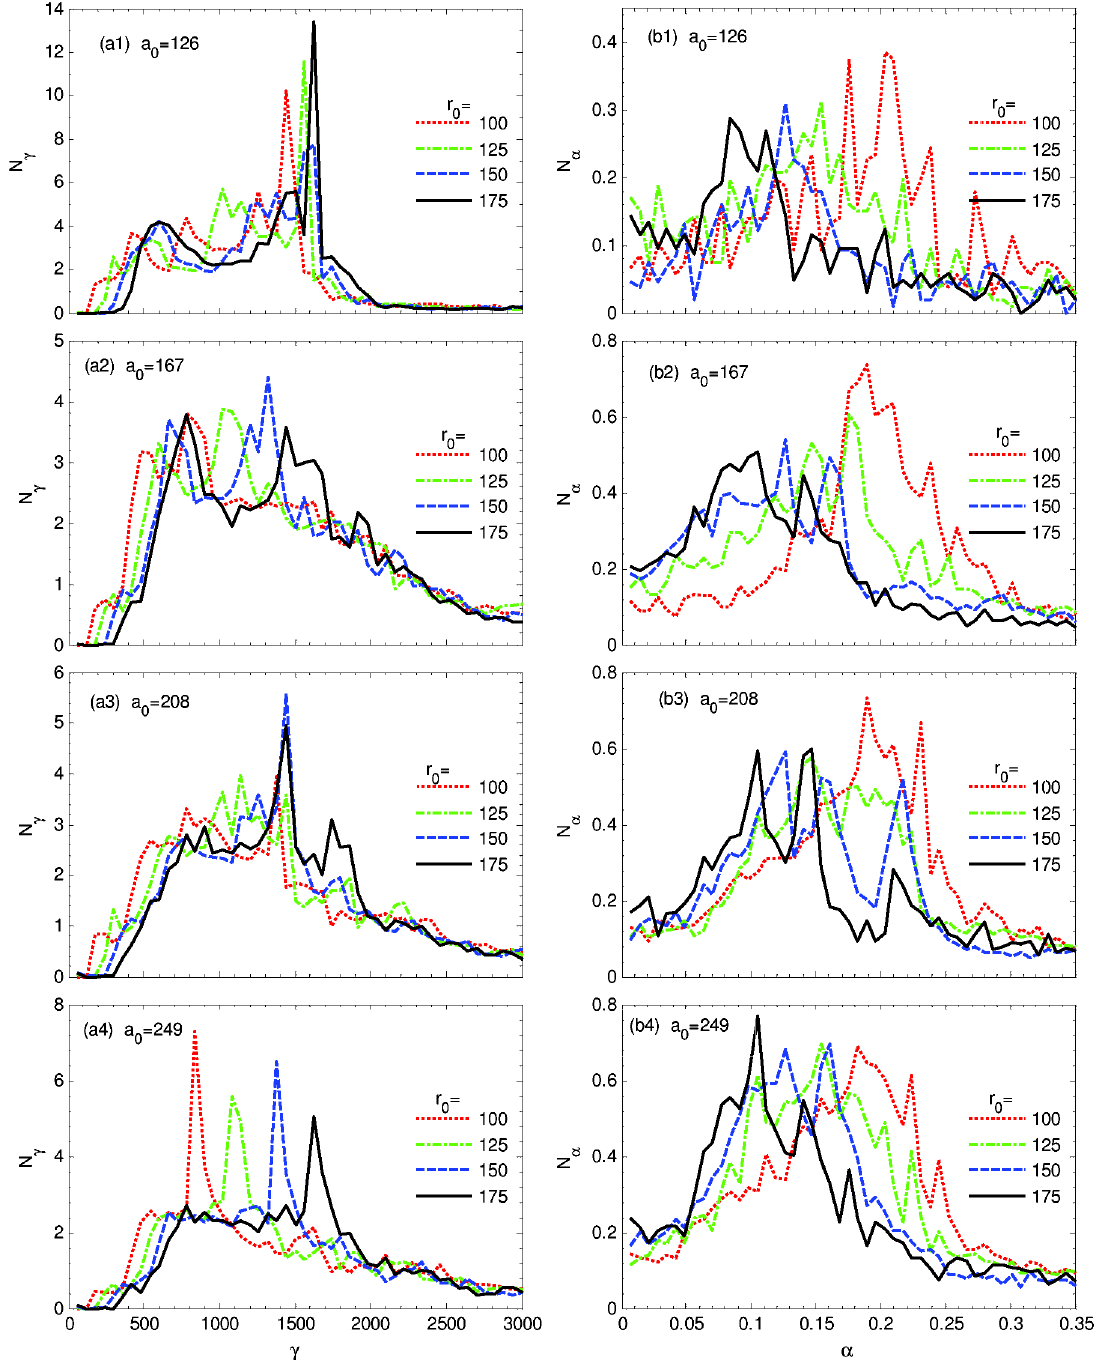
FIG. 10. Spectrum of (a1)–(a4) energy and (b1)–(b4) angle of emittance of the electrons generated during ionization of argon by a laser pulse. The laser intensity parameters a 0 and laser spot size r 0 are specified in the figure itself. Here N (cid:5) and N (cid:8) are the number of electrons (relative scale) with energy lying within a range of relativistic factor and scattering lying within a range of angle of emittance,